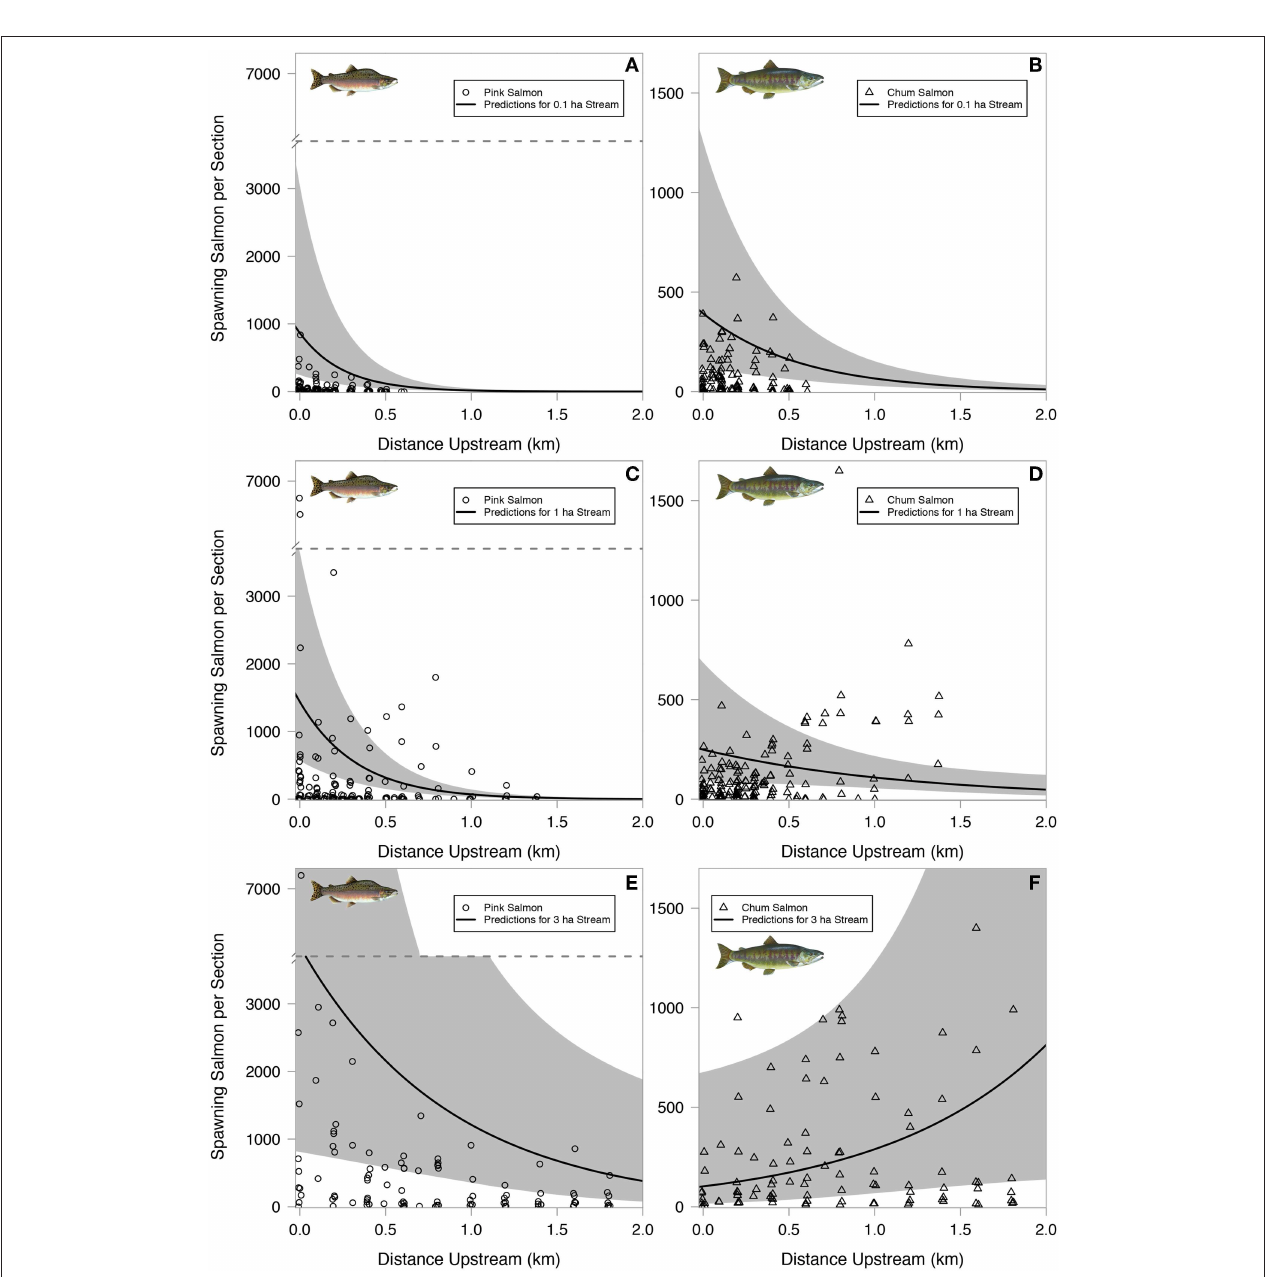
FIGURE 4 | Live chum and pink salmon distributions. Pink salmon in left column, chum salmon in right column. The top row (A,B) shows observed data points for small streams, defined as the lower 25th percentile of stream areas. The prediction lines are for the top model and are based on a stream with 0.1 ha spawning area. The middle row (C,D) illustrates a medium-sized stream, with observed data points between the 25th and 75th percentile of stream areas, and prediction lines for a 1 ha spawning area stream. The bottom row (E,F) shows observed data points above the 75th percentile of stream sizes with prediction lines for a stream with a 3 ha spawning area. Shaded polygons indicate 95% confidence bands around model predictions.